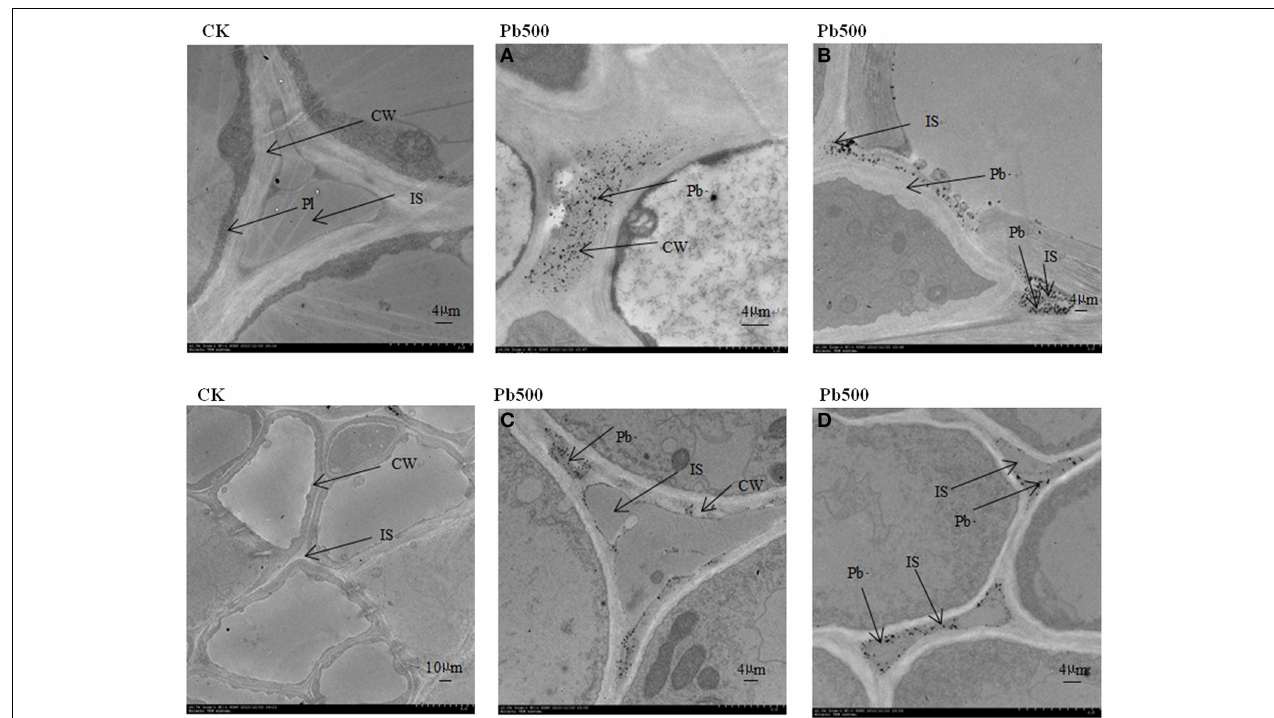
FIGURE 5 | Ultrastructure of transverse sections of lateral roots in NAU-XLM under 500mg/L Pb treatment. Electron-dense particles were localized in CW, cell wall (A,C) and IS, intercellular space (B,D) . Pl refers to plasmalemma.